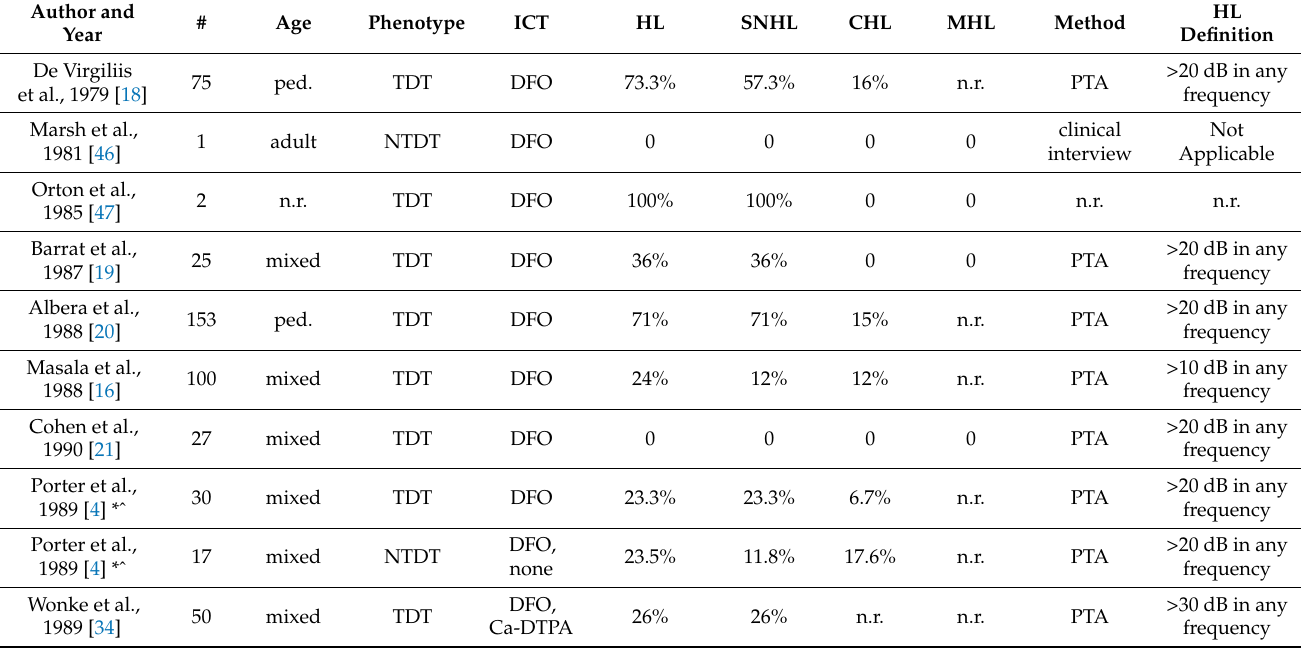
Table 1. Literature overview of hearing impairment in